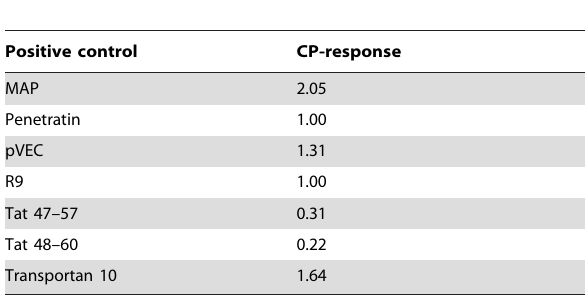
Table 2. Overview of the used positive controls in studies for cellular uptake of peptides and their CP-response.